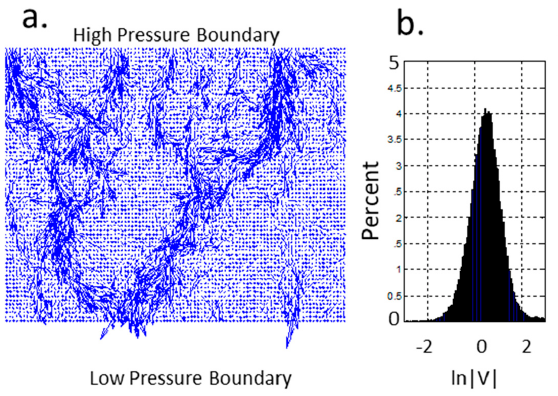
Figure 7. a . The flow field, computed for a medium with a permeability that varies by ± 2 natural log units (see Figures 2–4 well-core data) and has a 1 / k spatial distribution of ln κ , shows dramatic channeling between the high- and low-pressure boundaries. b . Distribution of natural log-well log-flow velocity, ln (V), where V is in arbitrary units